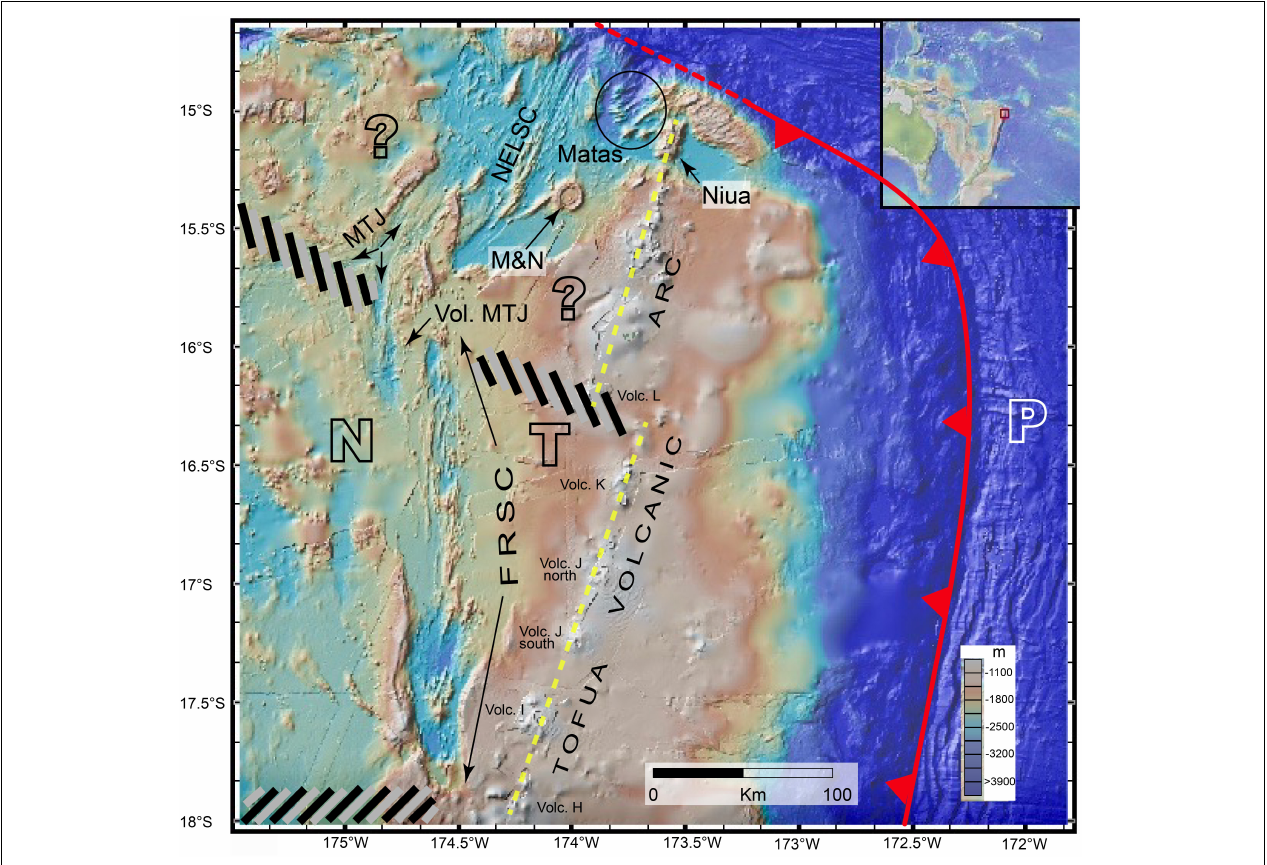
FIGURE 1 | Hydrothermally active areas of the NE Lau Basin. Spreading centers along the Mangatolou Triple Junction (MTJ) and the Fonualei Rift and Spreading Center (FRSC), separate the Tonga (T) and Niuafo’ou (N) plates. The southern N-T boundary is a diffuse boundary or a deformation zone, (right-tilting gray and black bars) (Sleeper and Martinez, 2016). The NE Lau Spreading Center (NELSC) is within an area where plate boundaries (north of the left-tilting gray and black bars) between N&T and more northerly plates (?) are undetermined (Conder and Wiens, 2011). Niua volcano is on the Tofua arc, whereas the nine Mata volcanoes, Motutahi (M), Niuatahi (N) and MTJ are intra-plate volcanoes. Other known but apparently inactive submarine Tofua arc volcanoes (H–L) are also labeled. The NE Lau Basin is constrained on the north by the subduction boundary between the T and Pacific (P) plates (solid red line) that becomes a subducting plate tear (dashed red line) after turning westward. Figure made with GeoMapApp